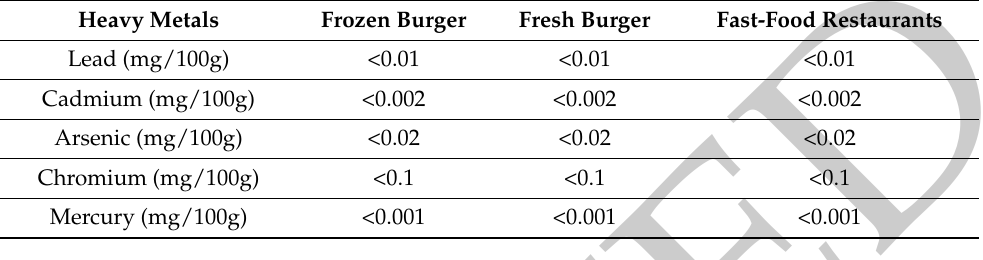
Table 6. Results of heavy metals analysis in the studied